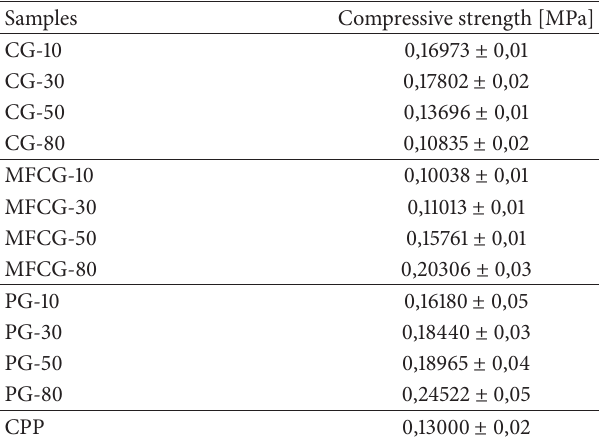
Table 2: Compression strength values of PUF samples.